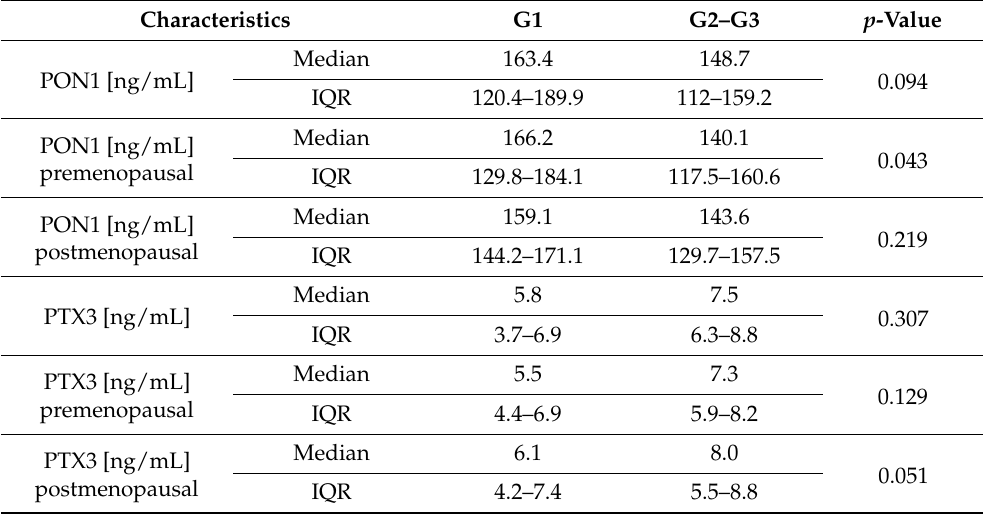
Table 4. Comparison of PON1 and PXT3 levels between patients with G1 and G2-G3 endometrial